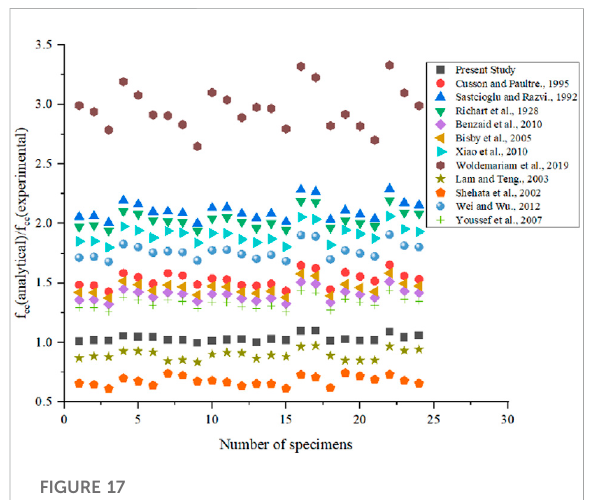
FIGURE 18 Predicted models for peak strain estimation without the longitudinal reinforcement.